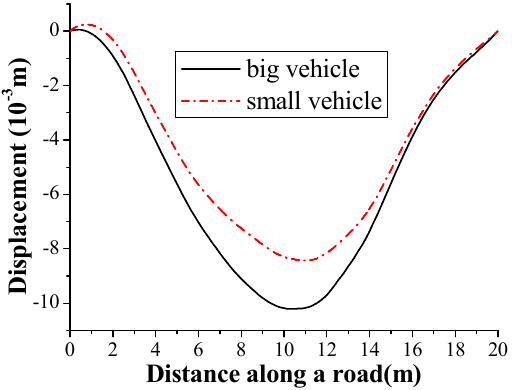
Figure 22. The average of three displacement responses on site.